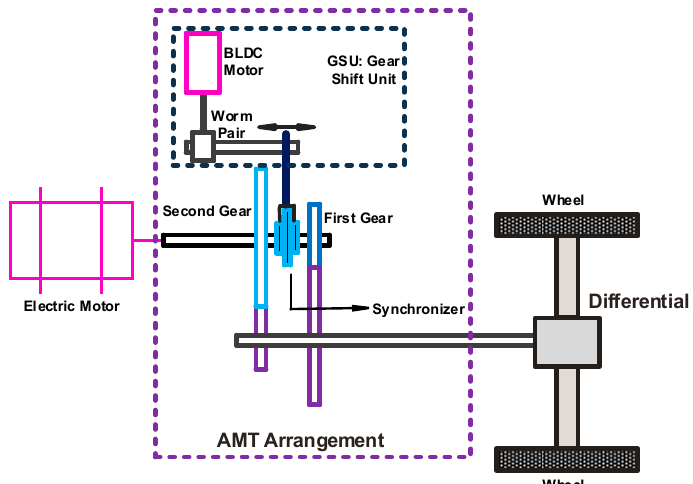
Figure 2. A typical automatic manual / mechanical transmission (AMT) layout within an electric vehicle (EV) powertrain.